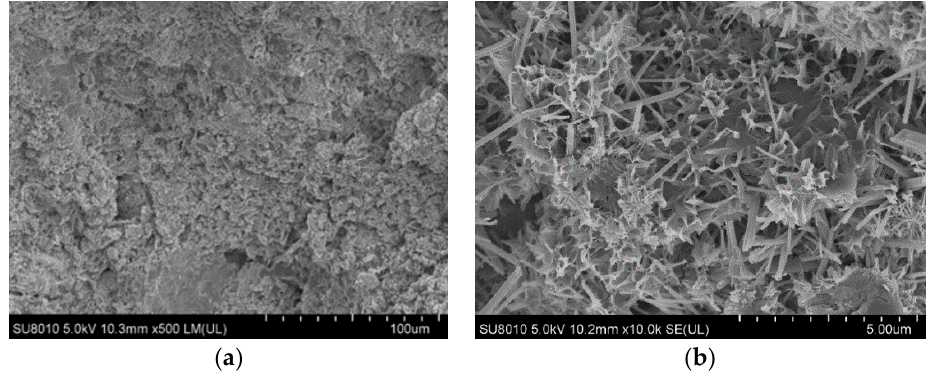
Figure 9. SEM photos of dry-mixed mortar after curing for 7 days. (a)x500 and (b)x10k Dry-mixed mortar is a mixture of cement, gangue, and admixture (active agent),